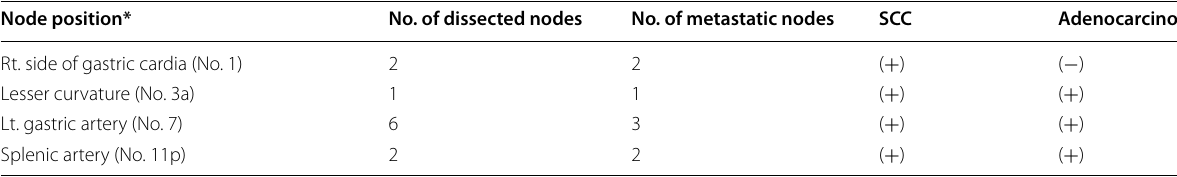
Table 1 SCC and adenocarcinoma in node metastasis